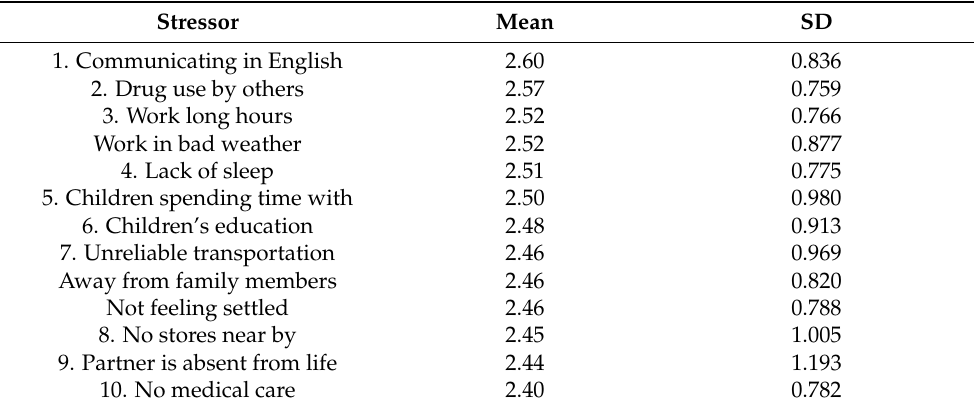
Table 1. Top Ten Work-Life Stressors Experienced by Latina Farmworkers. Stressor Mean